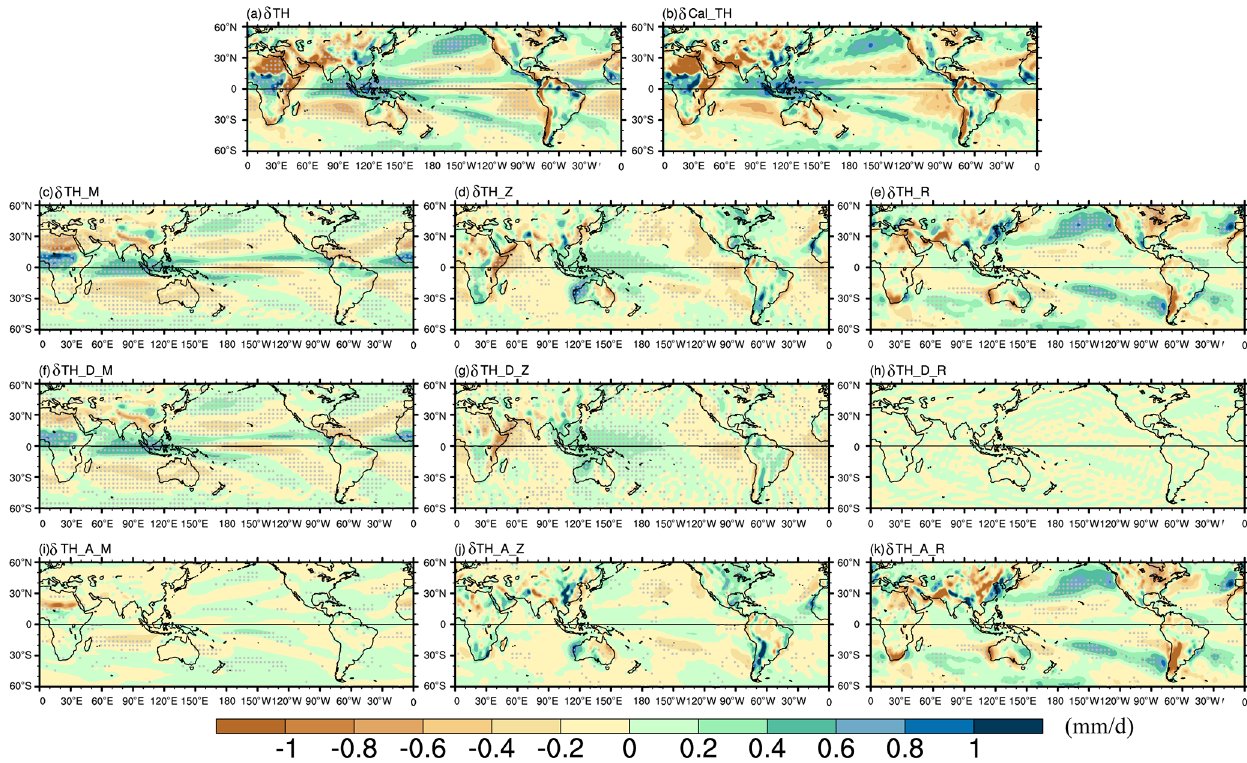
Figure 3. The annual mean changes in the moisture budget components of the mid-Pliocene minus the PI control of the PlioMIP2 multi- model mean, which reflect (a) the thermodynamic term and (b) the estimated change in the thermodynamic term (calculated as the sum of the right-hand side terms in Eq. (8) of the 3P-DGAC decomposition method). The contributions to the change in the thermodynamic effect include the thermodynamic term induced by the climate mean (c) meridional, (d) zonal, and (e) horizontal circulations. The corresponding changes in panels (f–h) and (i–k) are the terms in the components shown in panels (c–e) that are related to the divergent mean flow and change in moisture advection, respectively. Stippling indicates regions where at least 10 of 13 simulations in the model group agree on the sign of the ensemble mean. (Units are mmd − 1